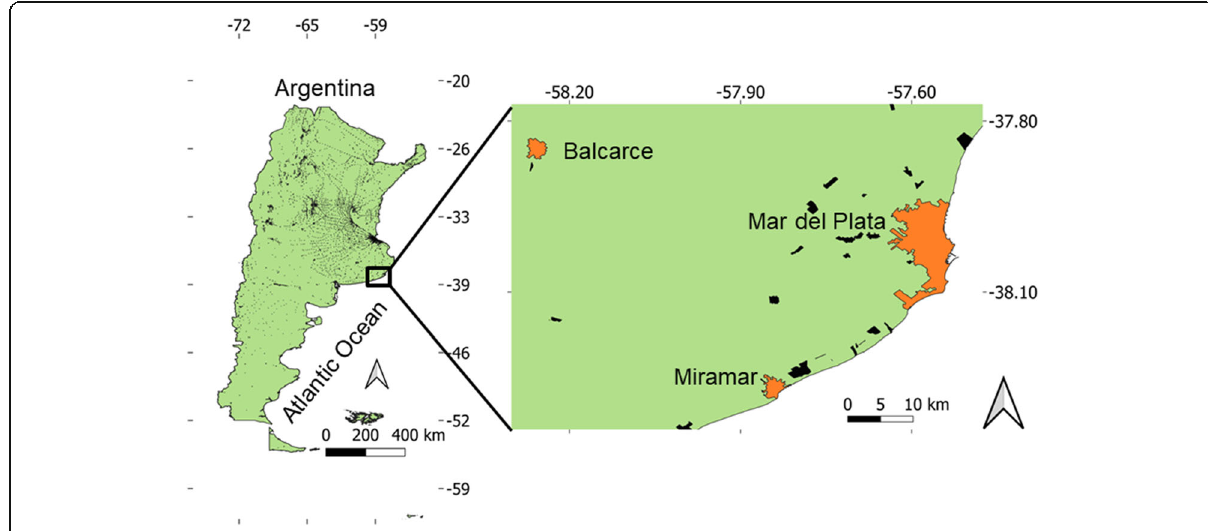
Fig. 1 Location of the three cities in central